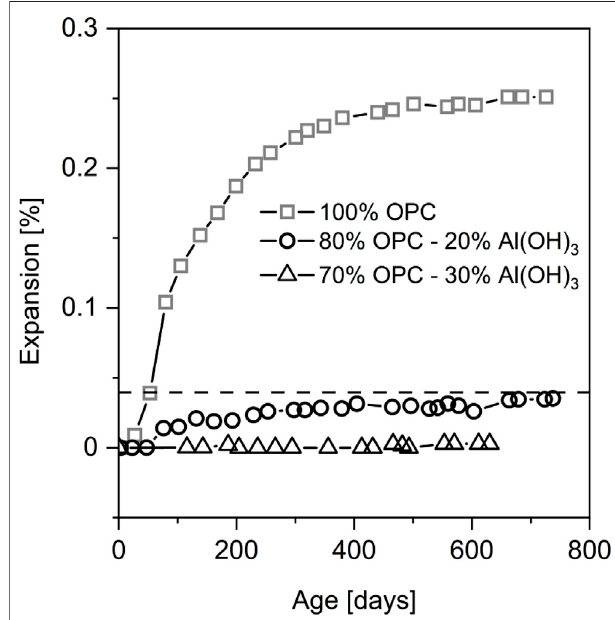
FIGURE1| ASRexpansionofconcreteprismscontaininghighlyreactive Spratt coarse aggregates and binder materials of control cement (OPC) partially replaced with Al(OH) 3 . Data from (Szeles et al.,